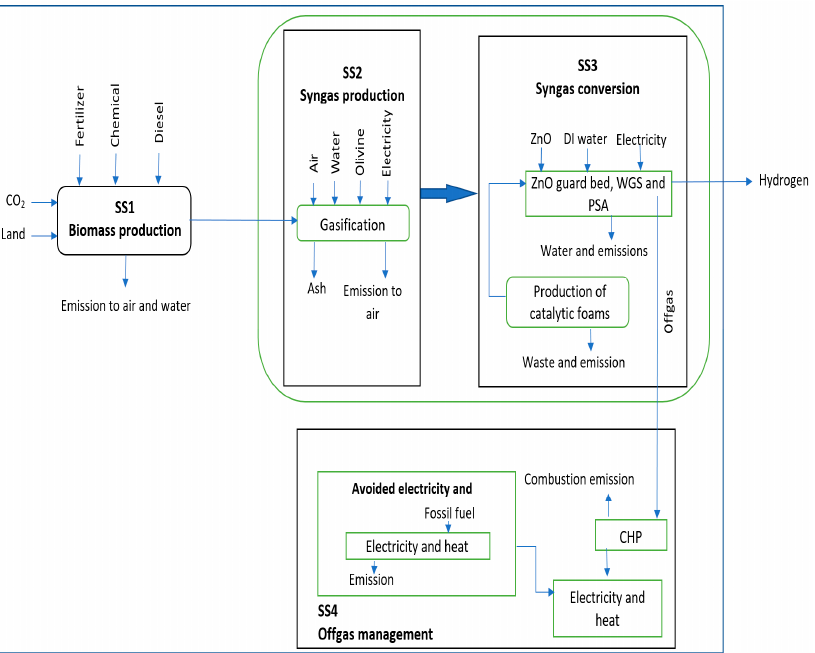
Figure 2. A picture of the plant.